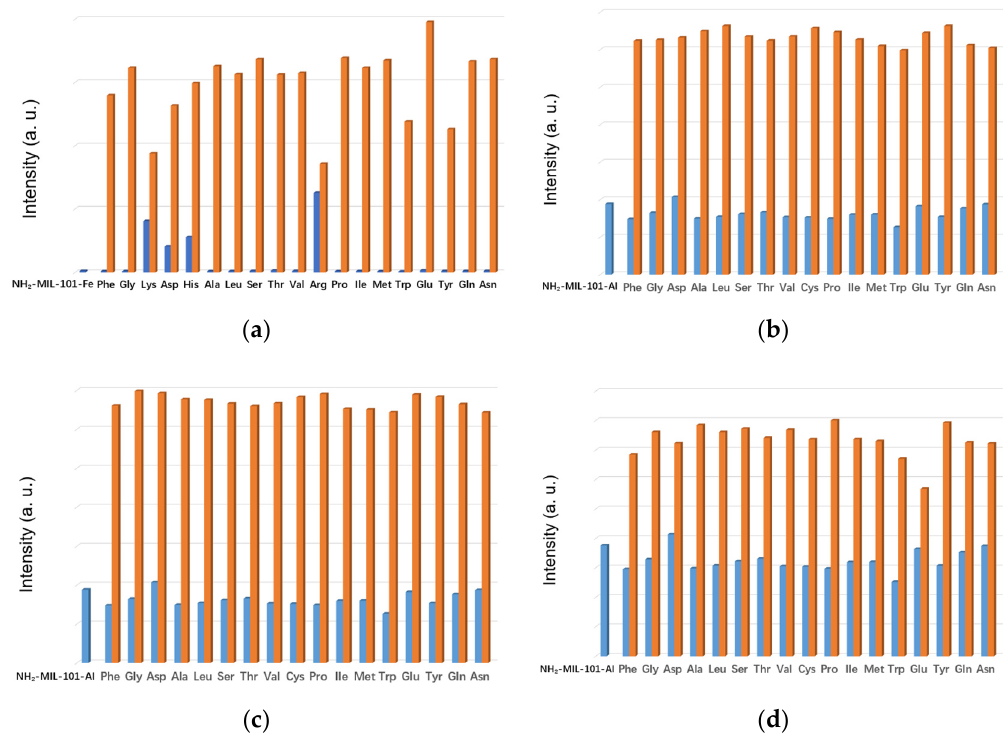
Figure 3. The emission intensities of the suspension of NH 2 -MIL-101-Fe with addition of competing AAs followed by addition of Cys ( a ) excited at 356 nm. The emission intensities of the suspension of NH 2 -MIL-101-Al with addition of competing AAs followed by addition of Lys ( b )/Arg ( c )/His ( d ) excited at 340 nm. (The emission spectra were obtained by using an optical attenuator owing to the measuring range of the emission intensity.).